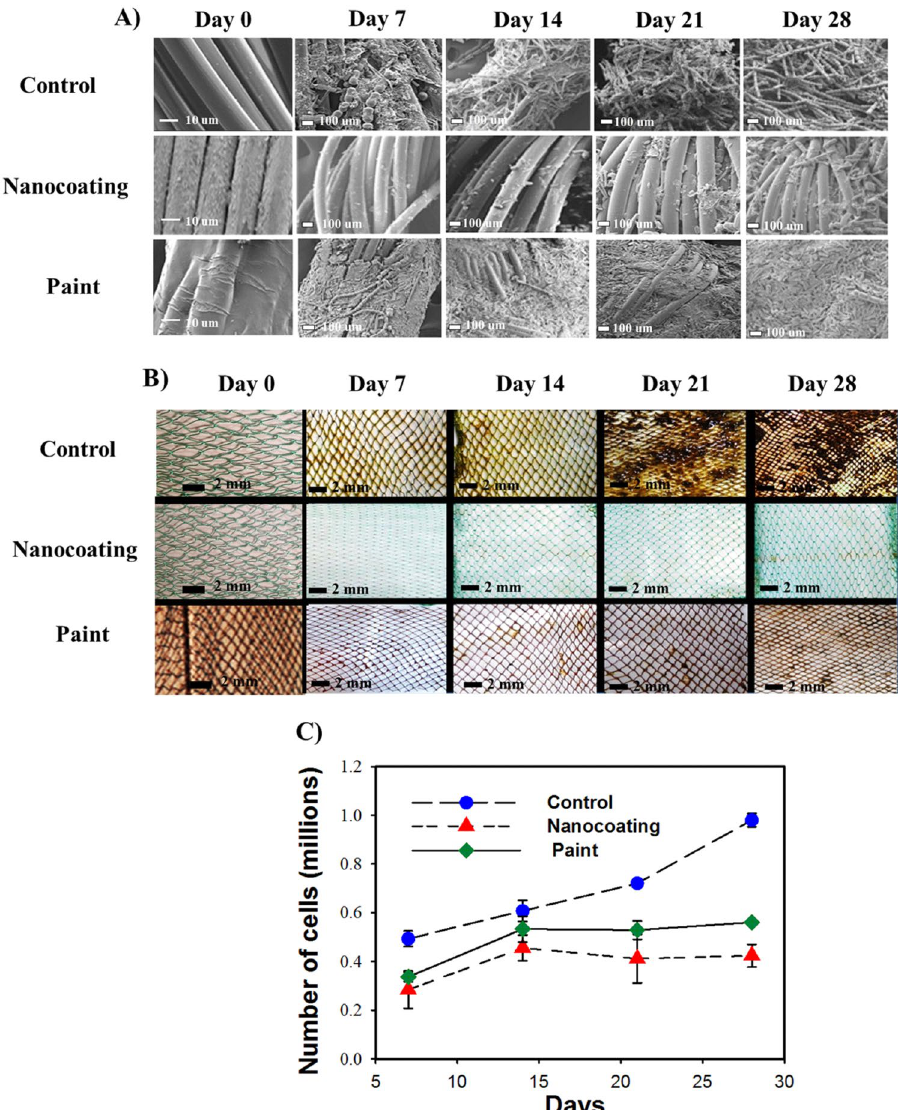
Figure 3. Surface coverage and total microbial abundance of the coated substrates. ( A ) Scanning electron micrographs of control, nanocoated and AF painted net substrates over the period of 4 weeks. ( B ) Sample optical micrographs of control, nanocoated and AF painted substrates over period of 4 weeks. ( C ) Variation in the total number of bacterial cells on the control, nanocoated and AF painted net substrates per millilitre as measured by flow cytometry over the period of 4 weeks. Day 0 counts are not shown as all the counts were zero. Reported values show average readings of 3 replicates ± standard